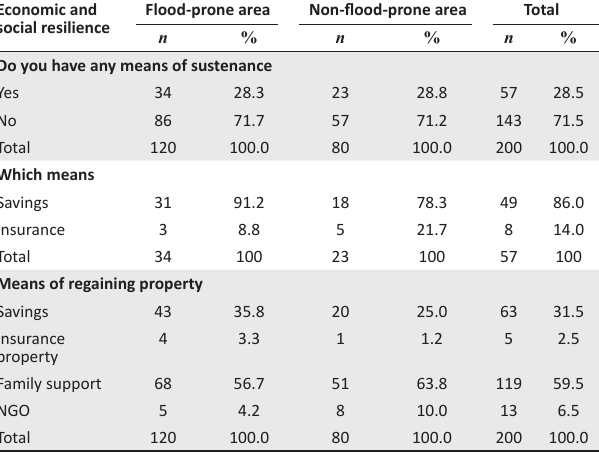
TABLE 6: Economic and social resilience to floods in Asamankese